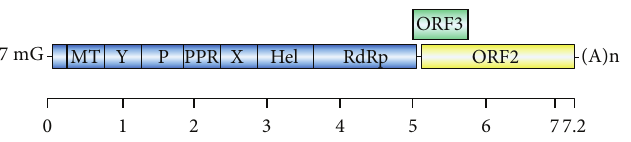
Figure 1: The structure of the hepatitis E virus genome. RNA length: 7.2kb. It has short 5 and 3 noncoding regions and three overlapping open reading frames (ORFs). ORF1 encodes the nonstructural proteins, including a methyl transferase (MT), cysteine protease (P), helicase (Hel), and RNA polymerase (RdRp), as well as three regions of unknown function (Y, PPR, and X). The 5 end of the RNA genome is capped with 7-methylguanosine (7 mG), and the 3 end is polyadenylated (poly A).